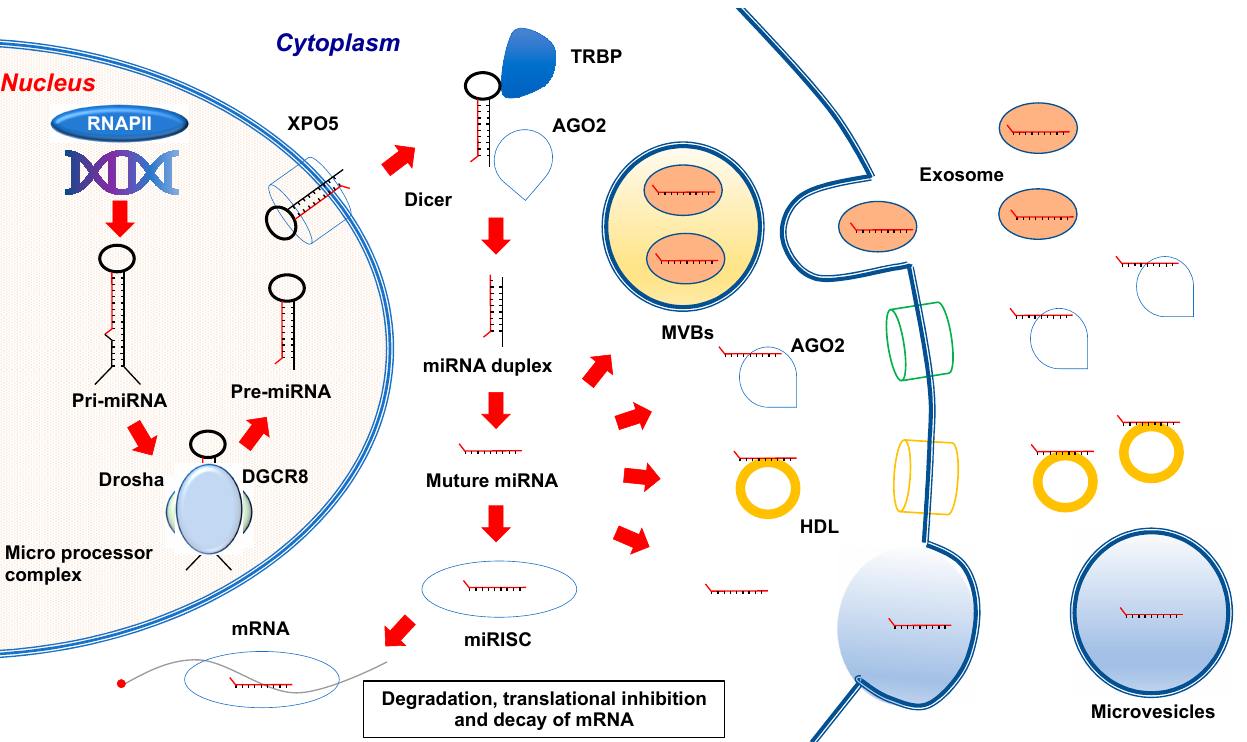
Figure 1. MicroRNA biogenesis. miRNAs are transcribed from the genome by RNA polymerase II (RNAP II) into primary transcripts (pri-miRNA) in the nucleus. Then, pri-miRNAs are cleaved into precursor miRNAs (pre-miRNAs) by Drosha to form a microprocessor complex with the DNA-binding protein DGCR8. Pre-miRNAs are exported to the cytoplasm by exportin-5 (XPO5), and then, Dicer, transactivating response RNA-binding protein (TRBP), and kinase R-activating protein (PACT) cleave pre-miRNAs in the cytoplasm. Finally, the guide miRNA generated by Dicer is loaded onto the RNA-induced silencing complex (RISC) consisting of Dicer, TRBP, PACT, and Argonaute 2 (AGO2), and subsequently binds to the 3 ′ UTR of the target genes, inducing degradation or translational inhibition of the target mRNA. Mechanisms for release of circulating miRNAs: (i) Release through exosomes: first, endosomes are formed by invagination. Then, mature miRNAs are loaded into multivesicular bodies (MVBs). Finally, they are released from the cell membrane as exosomal miRNAs; (ii) Release through AGO2 and HDL: AGO2 and HDL bind to miRNAs and can be released into the extracellular space; (iii) Release through microvesicles: Microvesicles (MVs) are spontaneously generated from cells by direct budding and contain mature miRNAs.